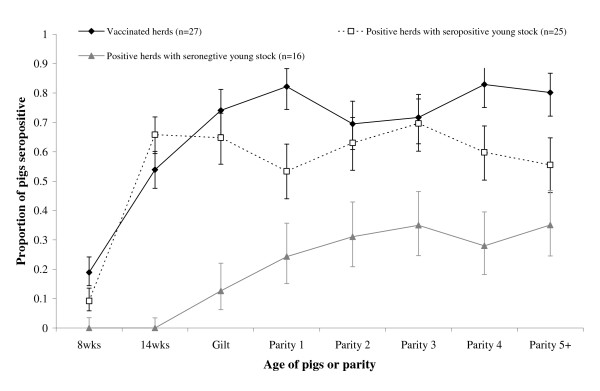
Proportion of pigs seropositive by age for 25 positive herds that had seropositive young stock, 16 positive herds that had seronegative young stock and 27 vaccinated herds. Bars indicate exact 95% confidence intervals. Lines are included for ease of visual interpretation only.